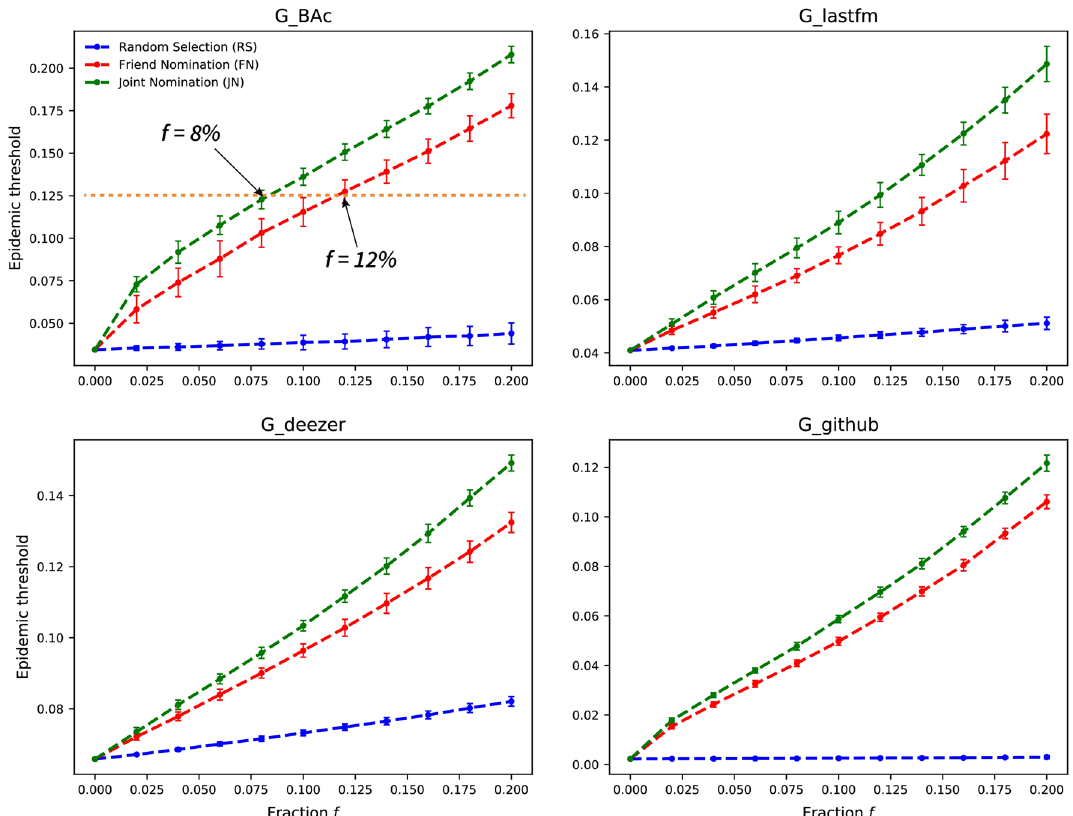
Figure 7. The trend of epidemic threshold with removing nodes identified with different strategies. Epidemic threshold for SP (blue, dashed line), FN (red, dashed line) and JN (green, dashed line) for SYN-BAc, G-Lastfm, G-Deezer and G-Github networks. The nomination strategies outperform the site percolation strategy with JN providing further improvement over FN. The results are averaged over 50 independent runs.